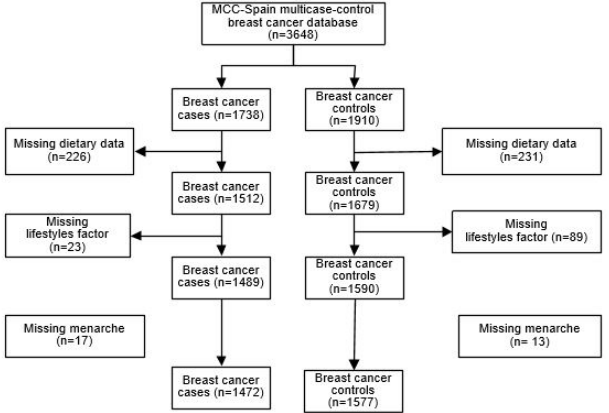
Figure 1. Algorithm for selection of breast cancer controls and cases in the multi-case-control (MCC)-Spain study.